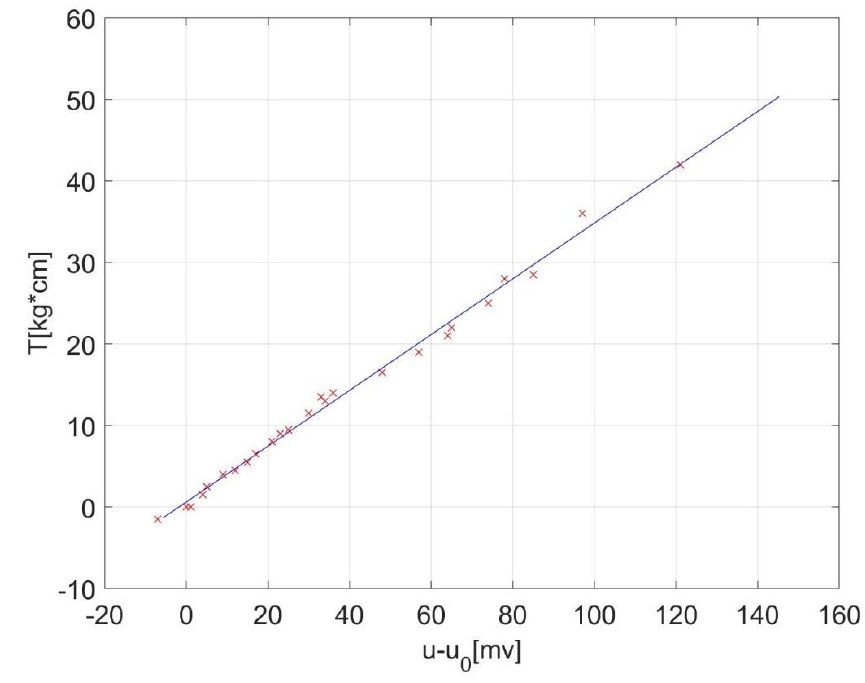
Figure 4. The result of linear regression (line) versus calibration measurements (crosses). Measured values with weights are gathered in Table A1, Appendix A containing weight, position and voltage. The torque was then calculated, and from the torque-voltage pairs, the proportionality constant was determined through linear regression.